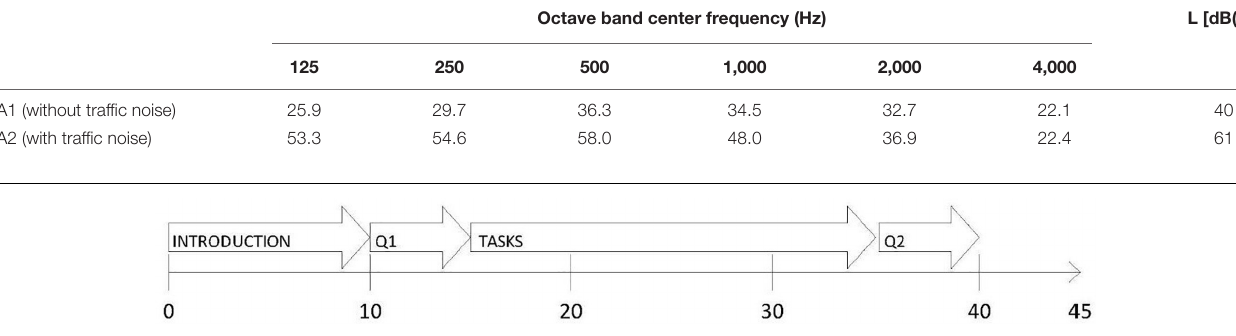
TABLE 4 | Frequency spectrum (octave band center frequency) for the two ambient sound conditions A1 and A2 (with/without noise).